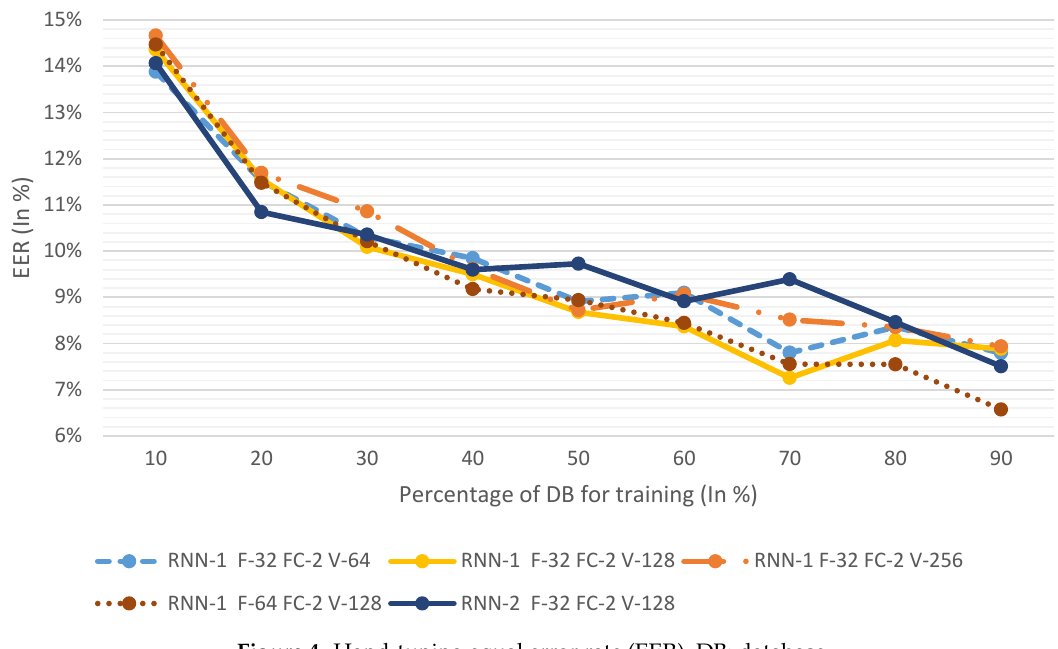
Figure 4. Hand-tuning equal error rate (EER). DB: database.